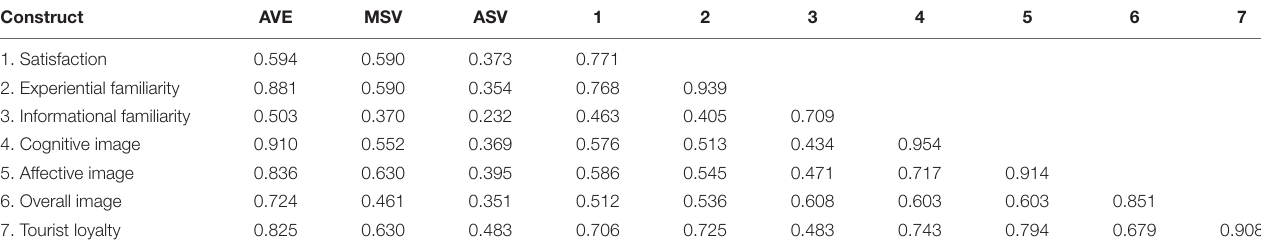
TABLE 3 | Discriminate